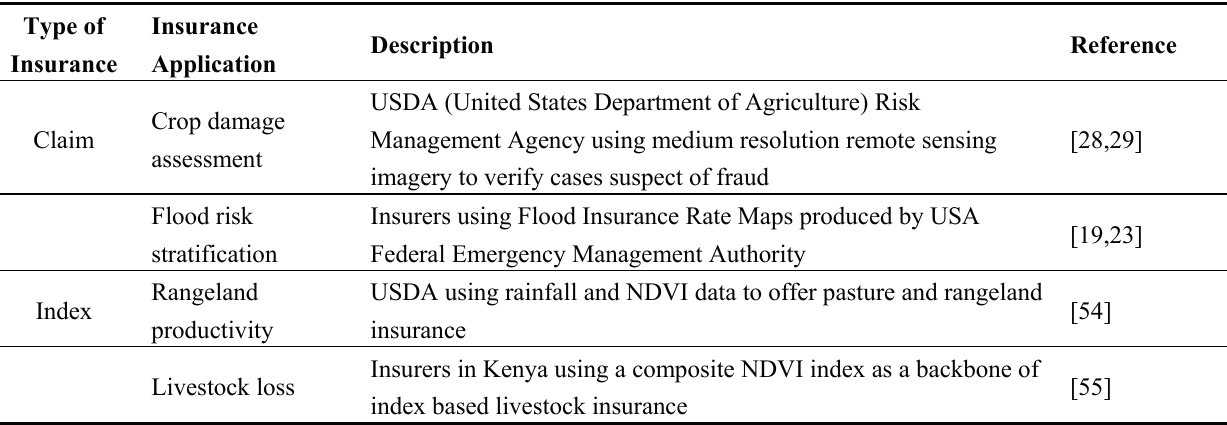
Table 2. Summary of papers describing operational application of remote sensing supporting the delivery of operational insurance